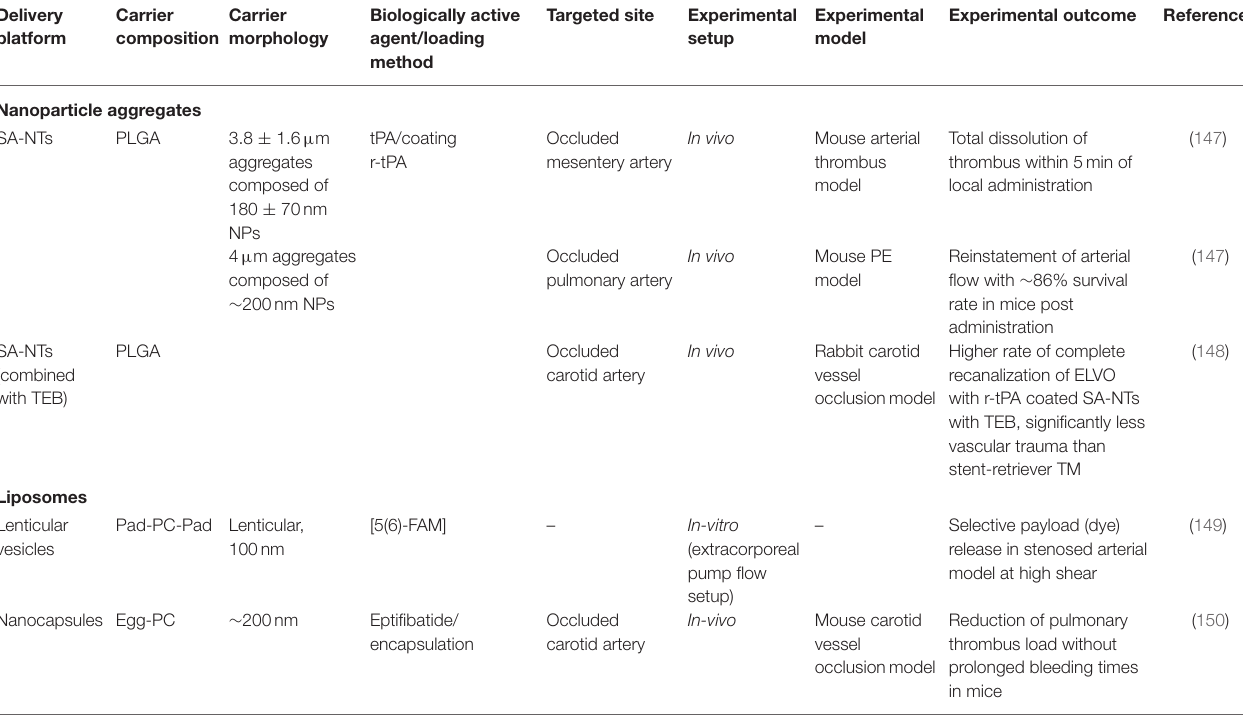
TABLE 2 | Outline of shear-sensitive drug delivery platforms targeting occluded blood vessels. Delivery